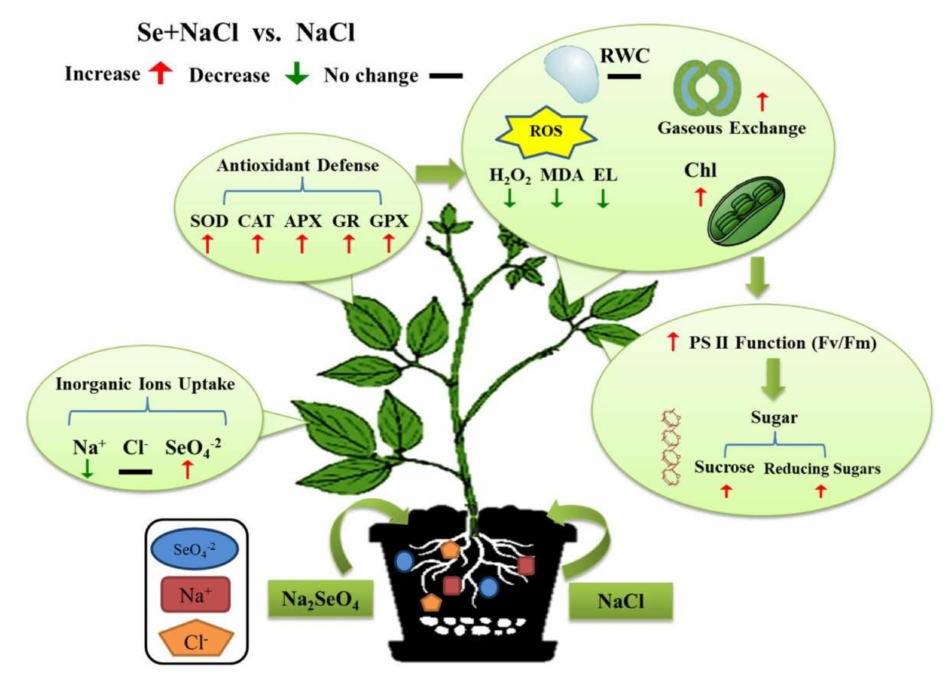
Figure 7. Comprehensive schematic diagram presenting the protective role of selenium (Se) at an optimum concentration (1.5 ppm) in leaves of black gram under salt